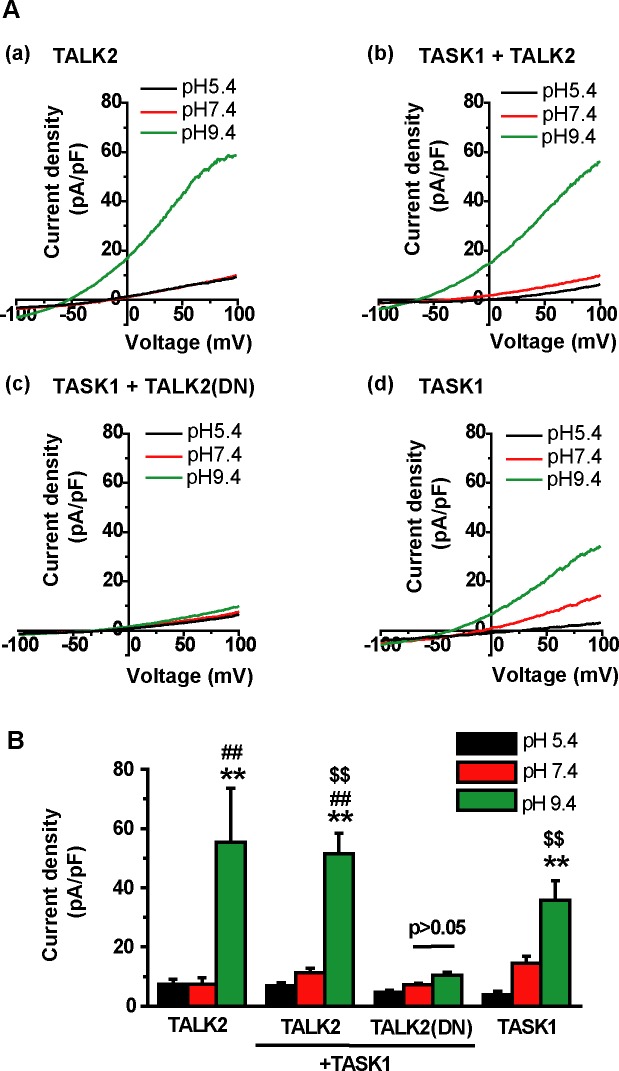
Effects of co-transfection of a dominant negative form of TALK2 on TASK1 currents.(A) Membrane currents were recorded using whole-cell patch-clamp techniques. Ramp pulse from +100 mV to -100 mV was applied to the cells at extracellular pH 5.4, 7.4 and 9.4. Here, constant amounts of cDNA of 0.2 μg GFP-TASK1 (A(b)-(d)), 0.6 μg TALK2-mCherry (A(a) and (b)) or 0.6 μg TALK2(DN)-mCherry (A(c)) were introduced to HEK293 cells. Therefore, cDNA ratio (TASK1:TALK2) in A(b) and A(c) was 1:3. (B) Averaged current density at +100 mV was compared. Number of cells in (a)-(d) was 4, 8, 8, and 6, respectively. **p<0.01 vs. pH5.4, ##p<0.01 vs. pH7.4, $$p<0.01 vs. TASK1+TALK2(DN) at pH 9.4.